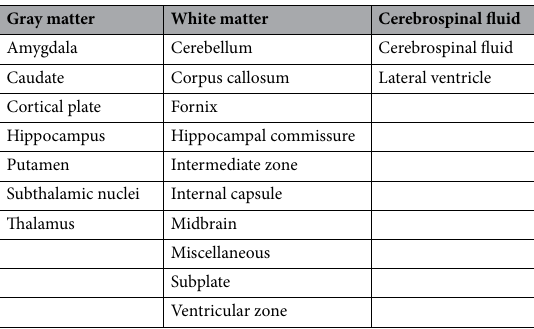
Table 1. Classification of segmented brain tissues 10 as gray matter, white matter and cerebrospinal